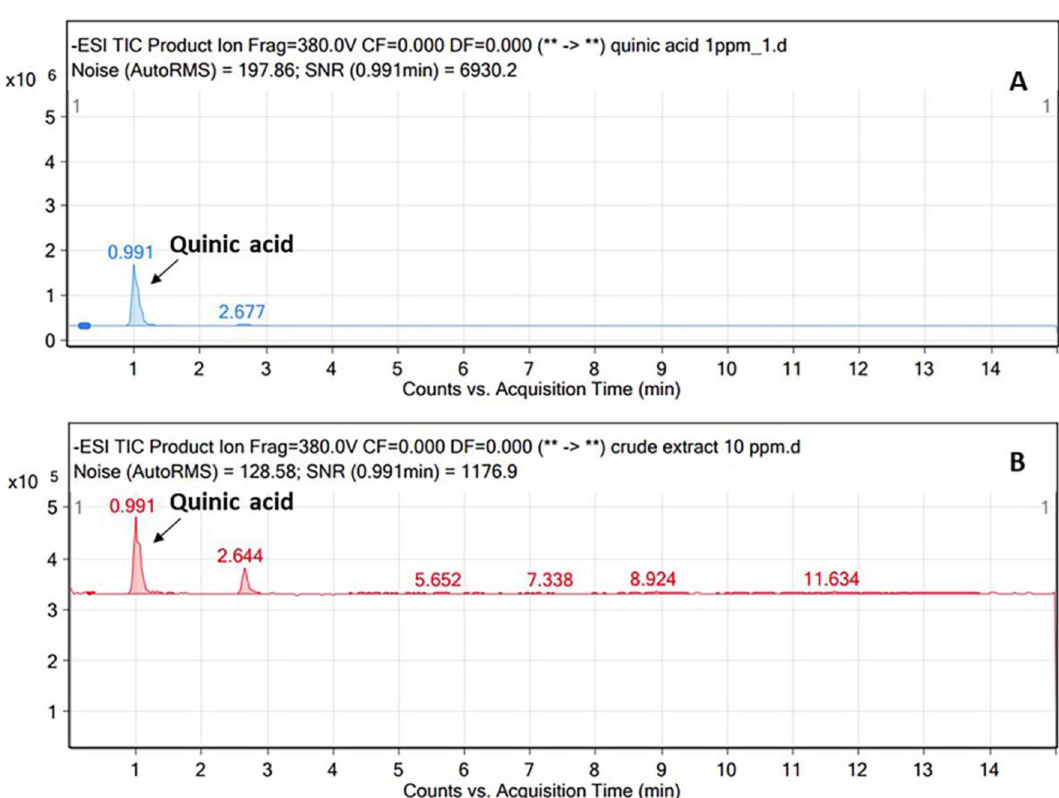
Figure 4. LC–MS chromatograms of ( A ) standard quinic acid and ( B ) quinic acid in F. dubia sap (FDS)